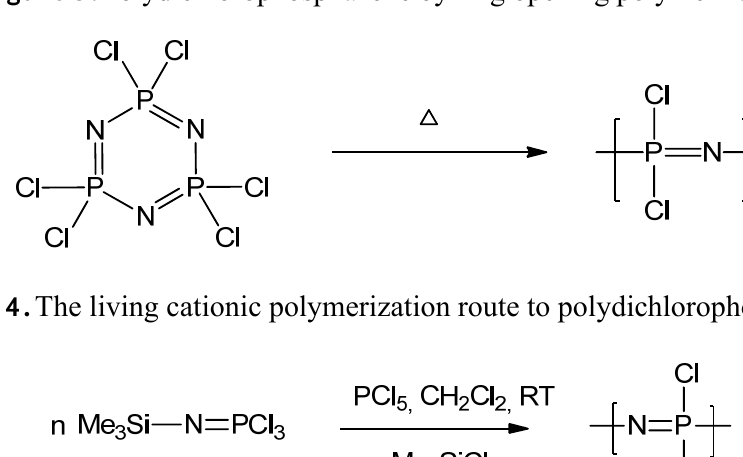
Figure 3. Polydichlorophosphazene by ring opening polymerization.